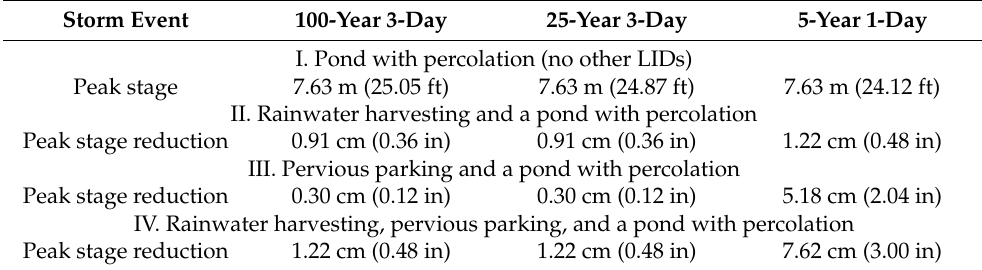
Table 11. Summary of the peak stages for the ICPR model run analyzing LID